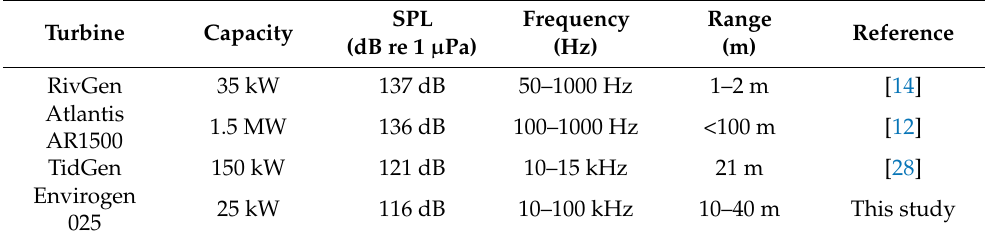
Table 2. Sound pressure levels recorded by drifting hydrophones from four marine and large riverine